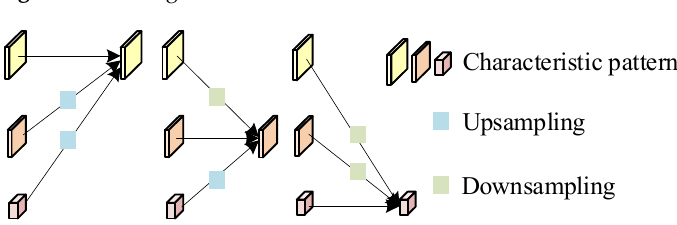
Figure 9. Exchange unit.